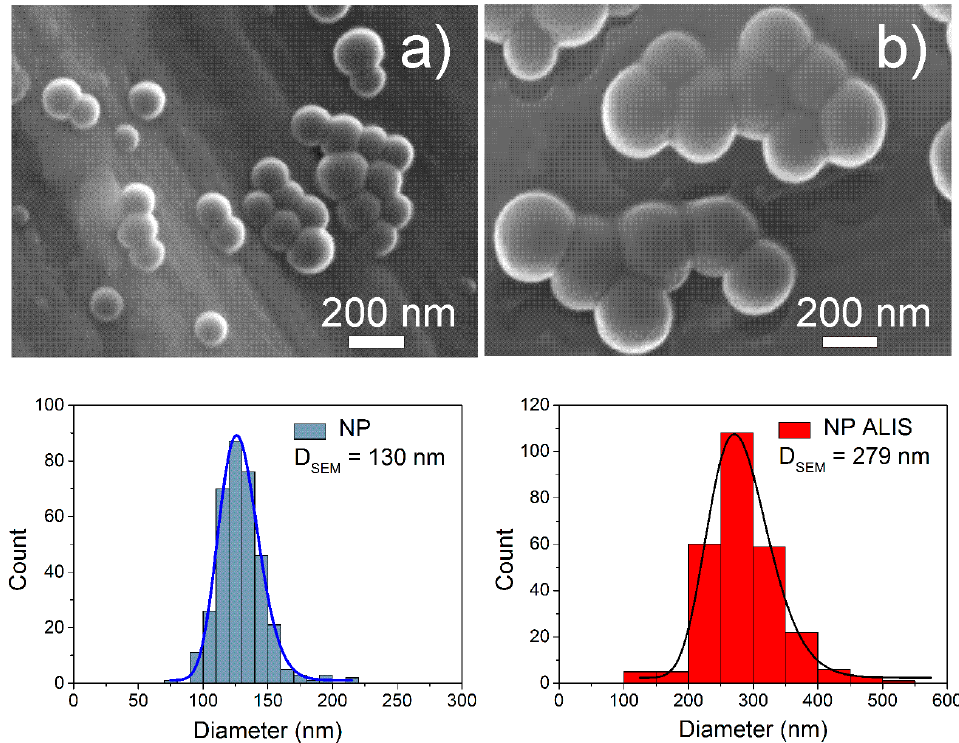
Figure 1. SEM images of nanoparticles (NP) ( a ) and nanoparticle-loaded aliskiren (NP ALIS) ( b ) with corresponding histograms of particle size obtained from the SEM images. Table 1. Characterization of NP, and NP ALIS. D SEM —mean nanoparticle diameter determined from